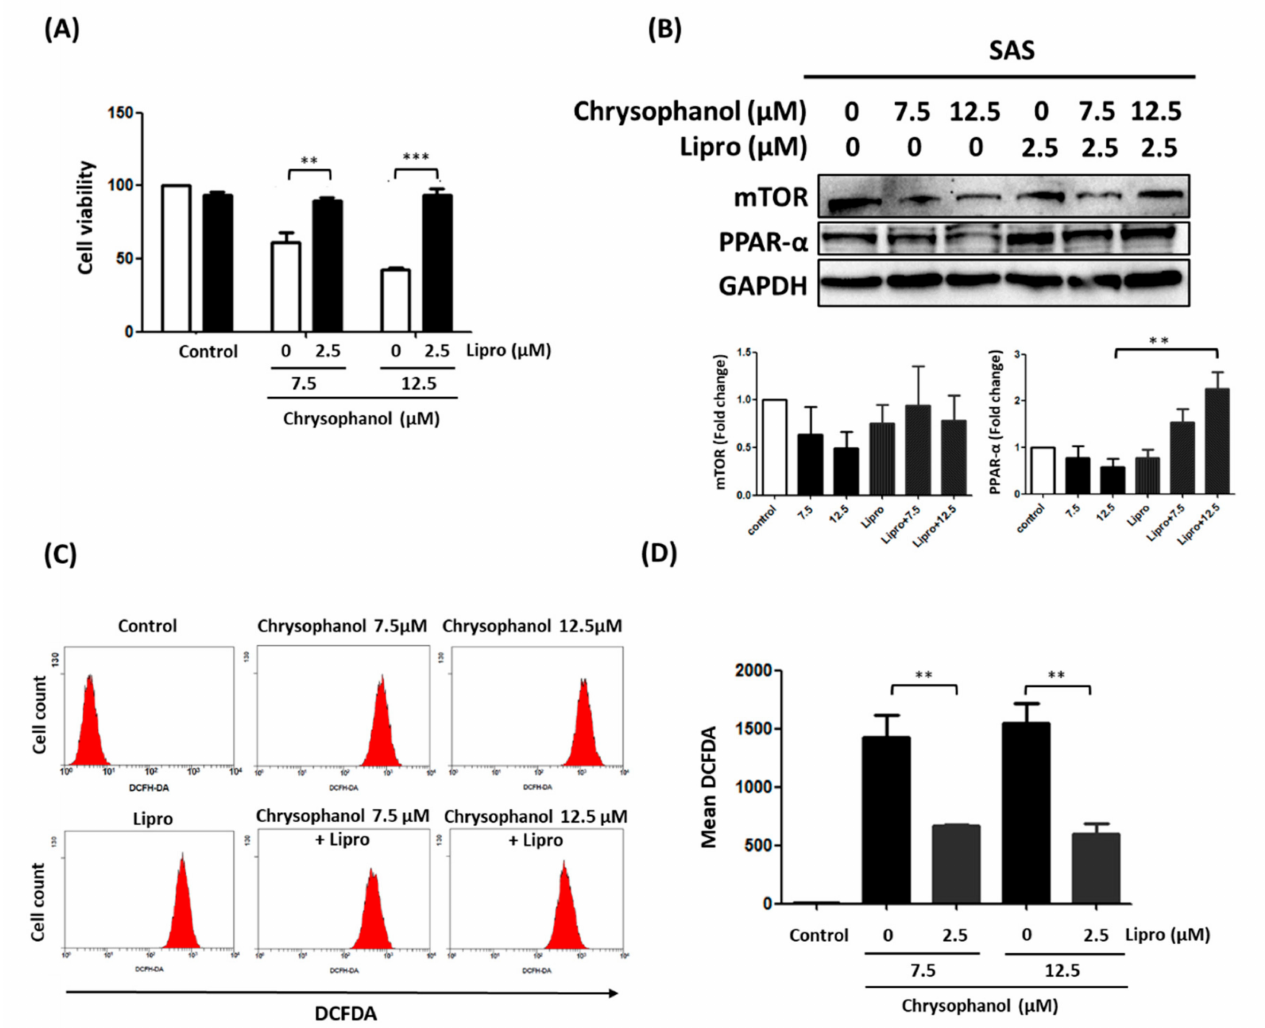
Figure 3. Effect of Lipro on cell survival, mTOR/PPAR- α expression, and ROS production in chrysophanol-treated SAS cells. ( A ) WST-1 was used to measure viability of cells in indicated groups. ( B ) Upper panel indicates expression changes of mTOR and PPAR- α proteins in the presence of 0, 7.5, and 12.5 µ M chrysophanol with (2.5 µ M) or without Lipro treatment. Lower panel indicates quantitative results of assessing specific proteins using ImageJ. ( C ) Changes in ROS levels (with 10 µ M DEFDA staining) with 0 (control), 7.5, and 12.5 µ M chrysophanol treatment with (2.5 µ M) or without Lipro treatment. ( D ) Mean fluorescence intensity was used to measure lipid ROS levels. Three independent replicates were used to calculate standard deviation; n = 3. ** p < 0.01; *** p <